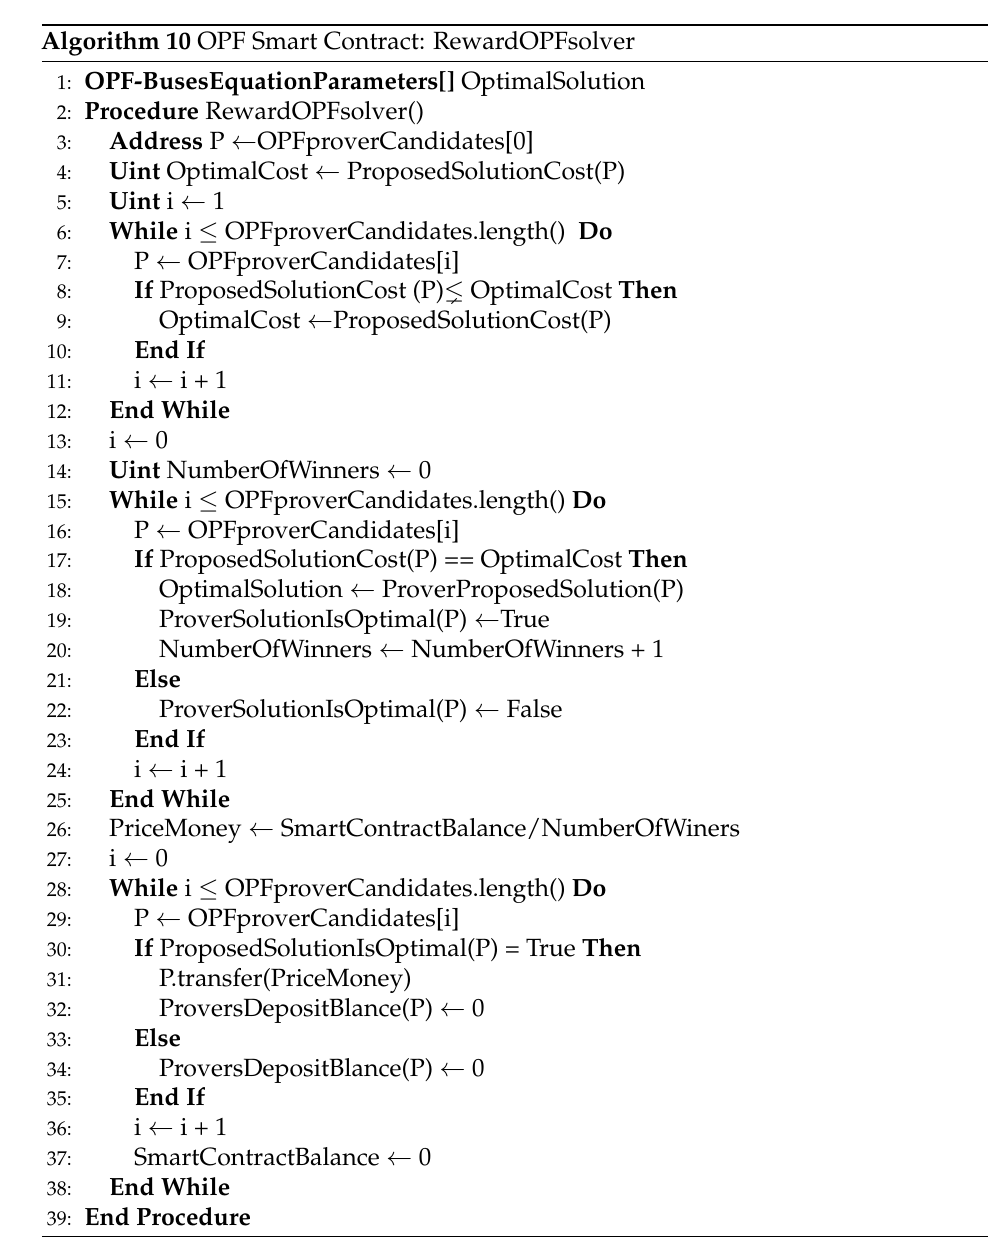
Algorithm 10 OPF Smart Contract: